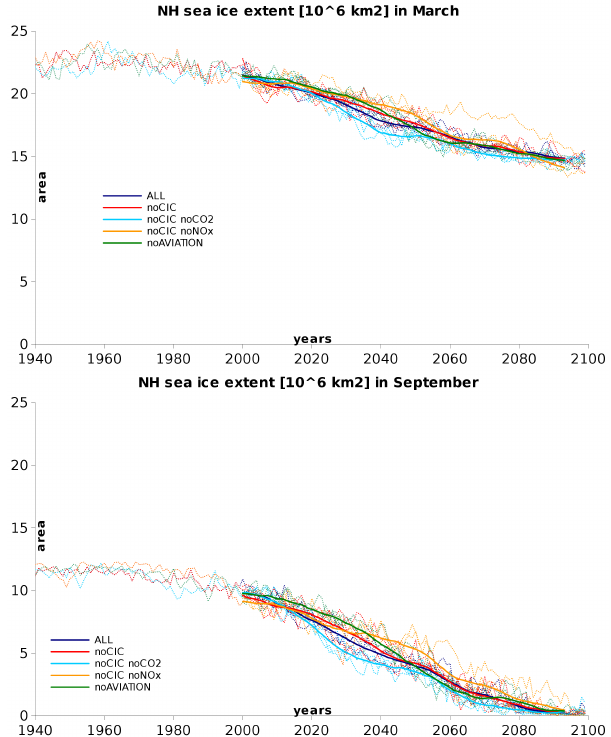
Fig. 6. The 1940–2100 evolution of the Arctic sea-ice area in September. Dotted lines represents yearly time series and solid lines the 11-yr running average of the three ensemble members for each experiment (see Table